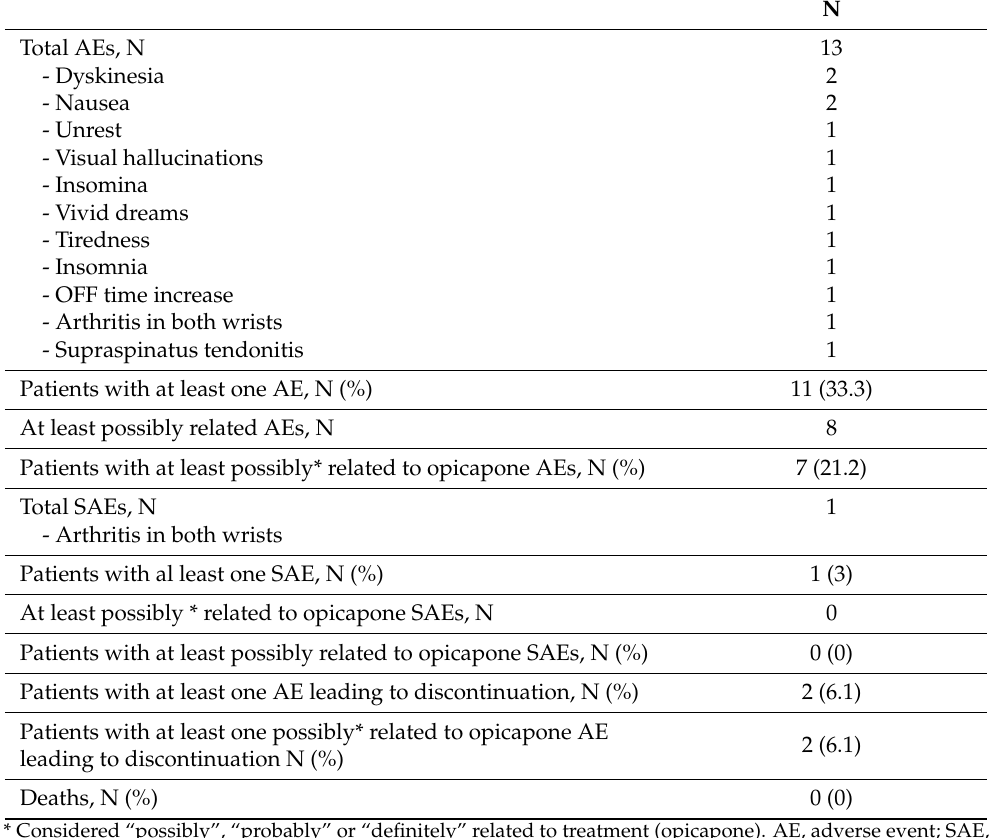
Table 3. Adverse events in patients from V0 to